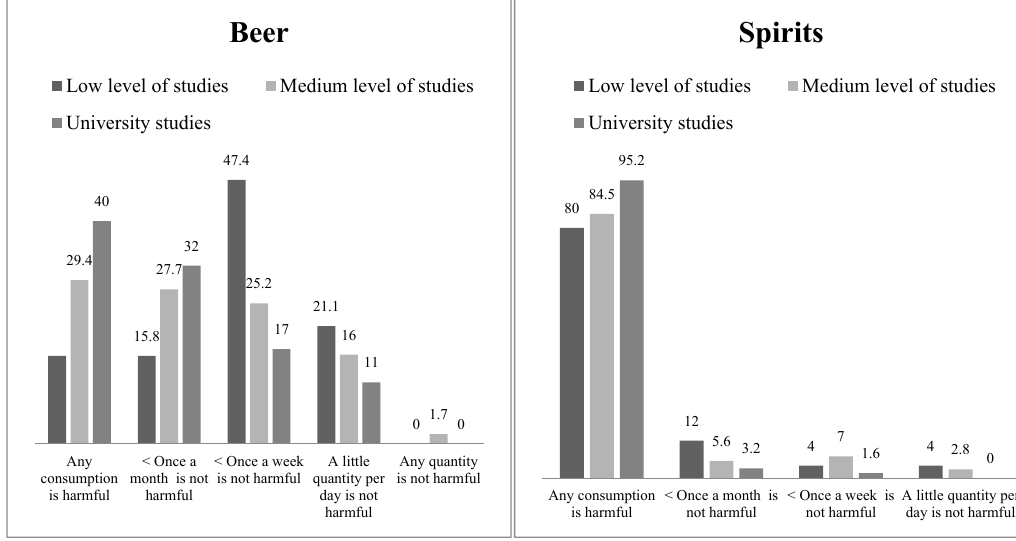
Figure 2. Beliefs concerning risks of drinking beer or spirits by educational level.